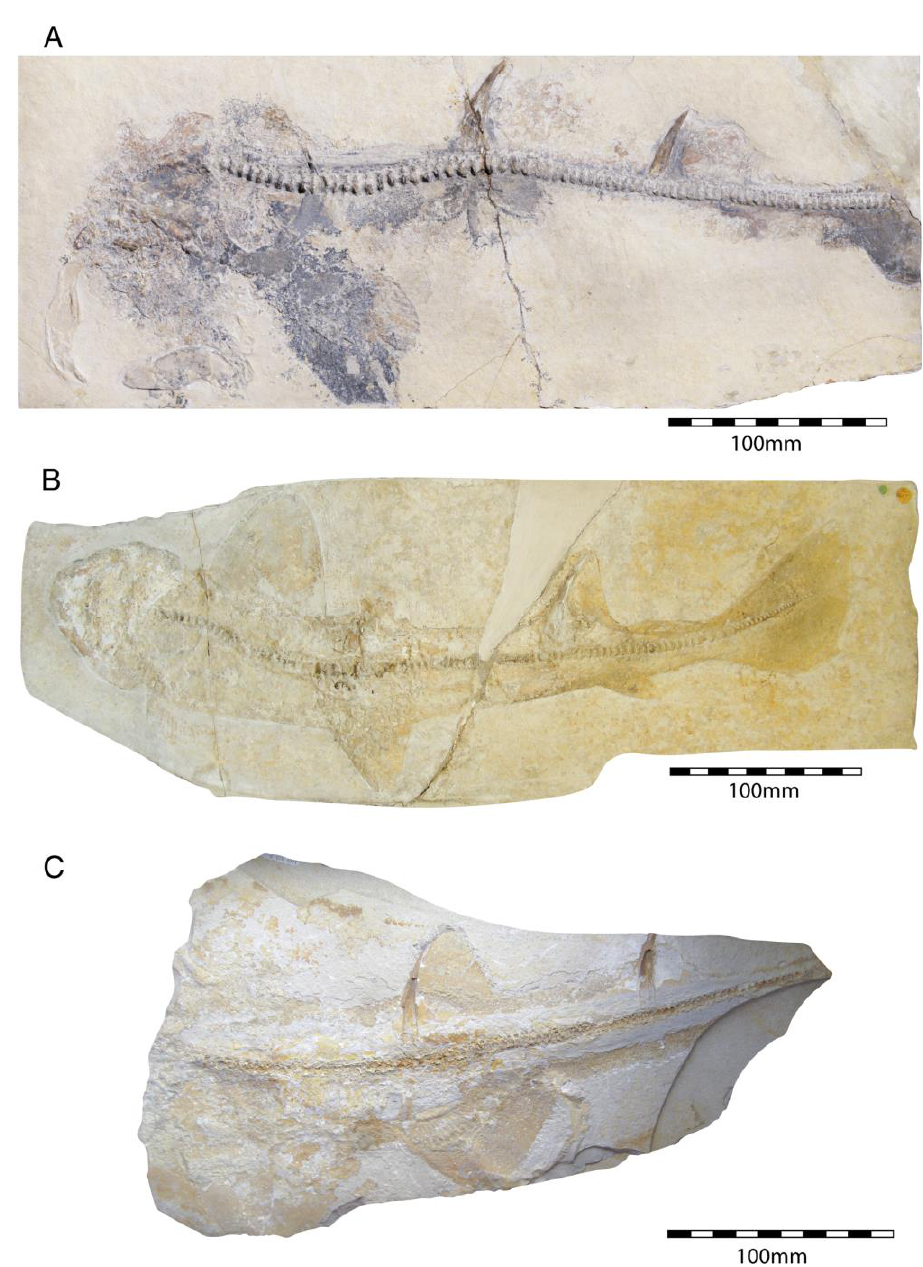
Figure 17. † Paracestracion falcifer Wagner, 1857 [100]. ( A ) Holotype specimen ( SNSB-BSPGM AS VI 505) from the lower Tithonian of Solnhofen. ( B ) Holomorphic specimen (NHMUK P 8657) from the Kimmeridgian of Eichstätt. ( C ) Almost complete specimen (JME SOS 2215) from the Kimmeridgian of Eichstätt.